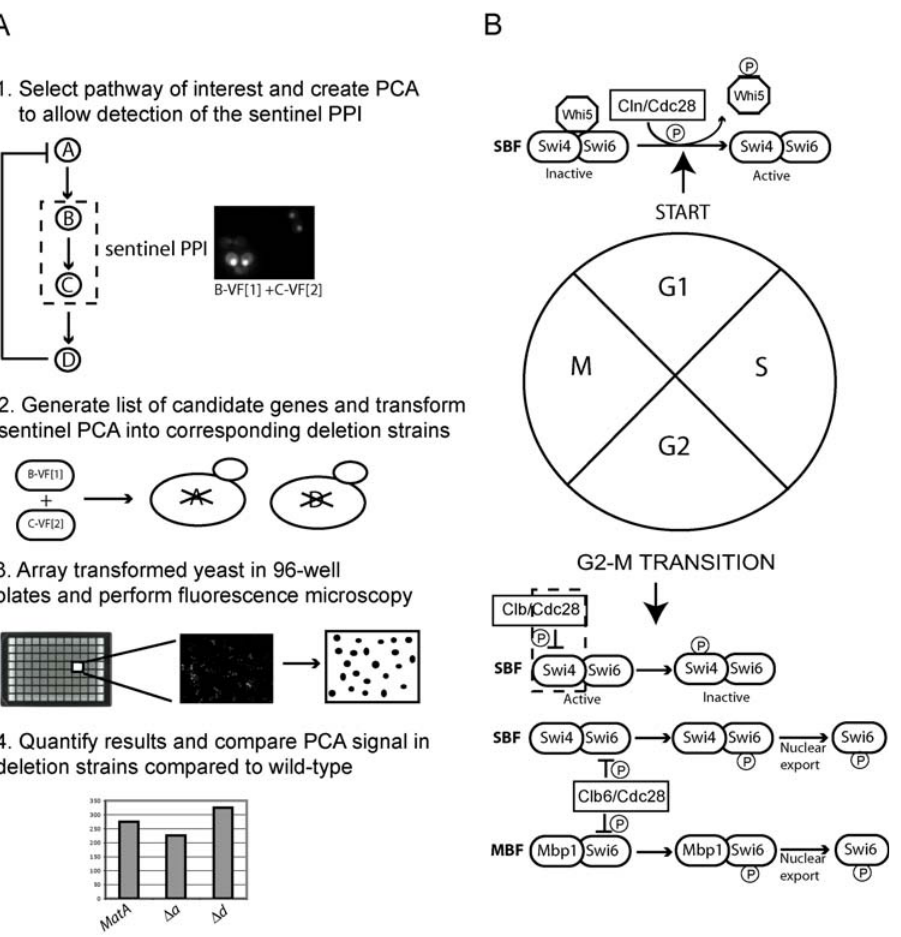
Figure 1. The GePPI screening strategy to identify proteins involved in the inactivation of SBF via phosphorylation by Clb/Cdc28. (A) A schematic representation of the GePPI screening strategy. 1) A biological pathway of interest is selected and a PCA assay is created that detects one or more sentinel PPIs of this pathway in wild-type yeast. In this example, protein A activates the sentinel interaction between proteins B and C, whereas protein D inhibits the interaction via a negative feedback loop. 2) Candidate genes are selected and plasmids encoding the PCA fusion proteins for each assay are transformed into the corresponding deletion strains. 3) Transformed deletion strains are screened in 96-well plates by fluorescence microscopy and images are collected and processed using image analysis software. 4) Strains are selected for which the PCA signal is significantly decreased or increased, as this type of analysis can be easily automated for yeast without the use of counter-stains that are required to identify changes in sub-cellular localization. In this example, deletion of protein A results in a decrease in the PCA signal, whereas deletion of protein D results in an increase in signal. (B) Regulation of SBF and MBF throughout the cell cycle. Activation of SBF involves phosphorylation of the SBF-associated repressor Whi5 by Cln/Cdc28 during G1. Phosphorylation of Whi5 leads to its dissociation from SBF followed by nuclear export. Inactivation of SBF in G2/M involves phosphorylation of Swi4 by Clb/Cdc28 activity. Regulation of MBF is less well understood but phosphorylation of Swi6 by Clb6/Cdc28 followed by Swi6 nuclear export may be a mechanism of inactivation of both SBF and MBF. The sentinel interaction between Cdc28 and Swi4 is indicated by dashed box.